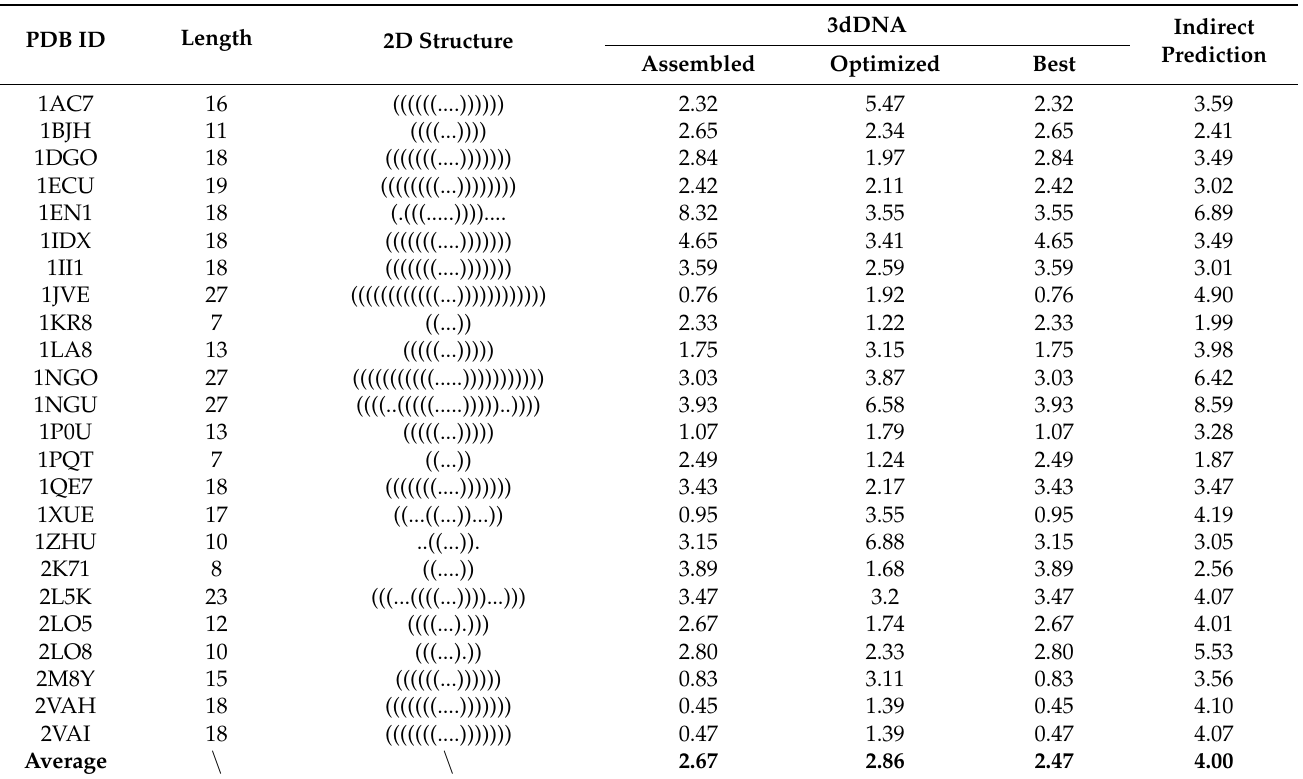
Table 4. Information and prediction accuracies (RMSD in Å) of 24